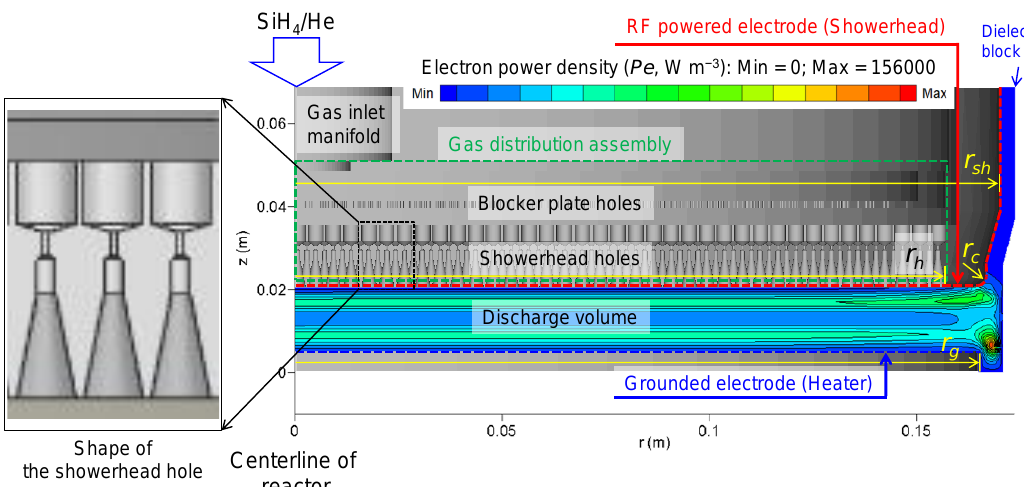
Figure 1. CCP reactor configuration is depicted with the reactor dimensions. The spatial variation in the electron power density ( P e , W m − 3 ) is superimposed. The inset shows the shape of the showerhead hole.